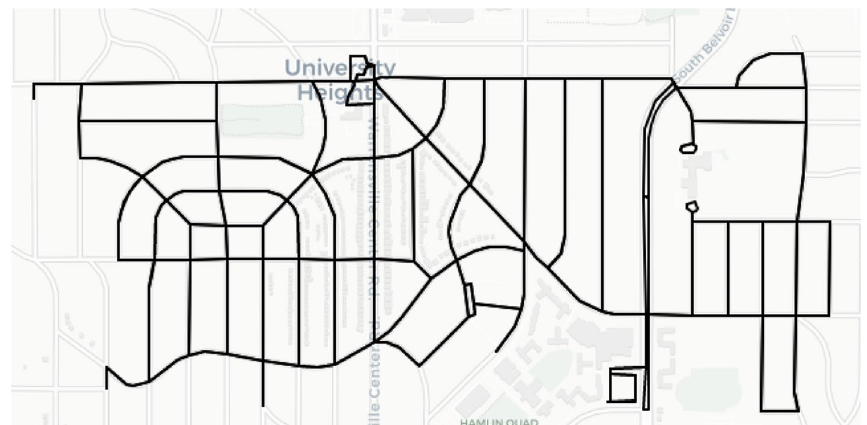
Fig. 13 Examined road network of University Heights, Cleveland, OH for case study